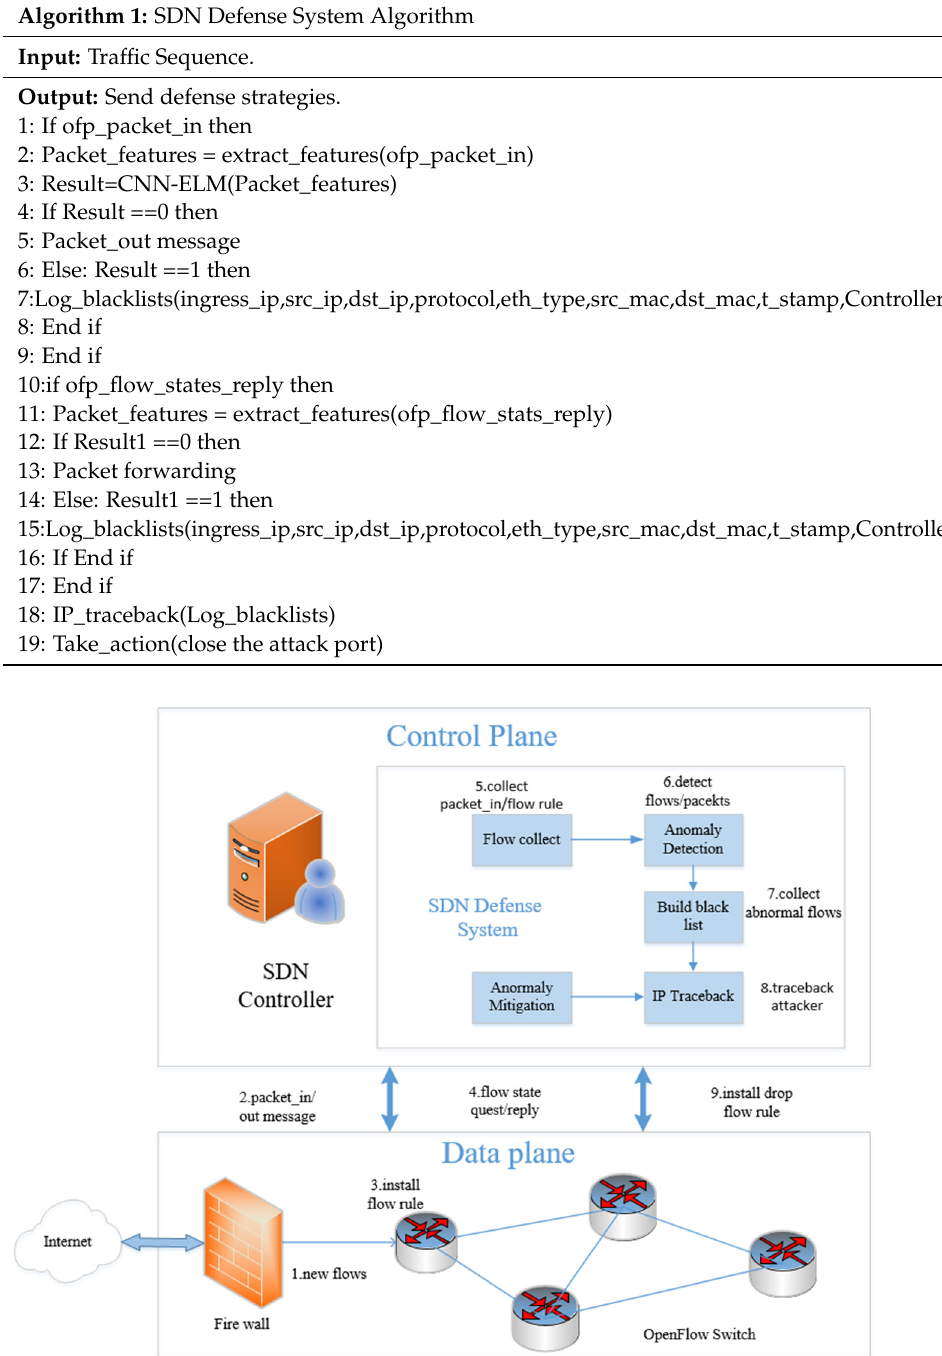
Algorithm 1. SDN Defense System Algorithm.